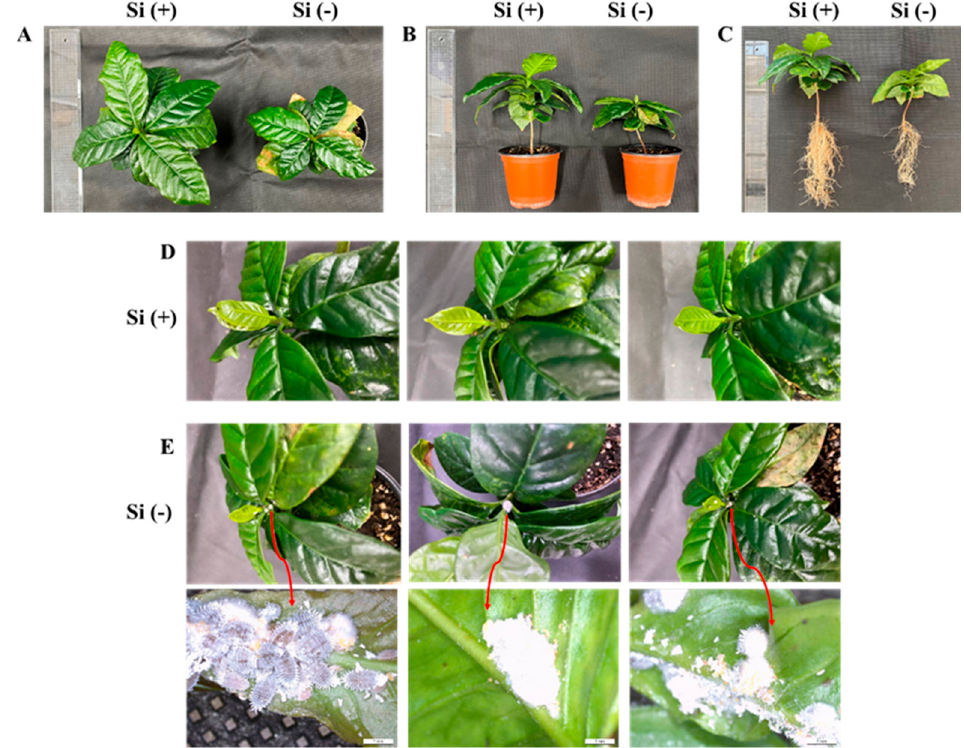
Figure 3. Effect of 30 days silicon application on morphology ( A – C ), disease, and insects ( D , E ) in the coffee plants grown in plant growth chambers. Si (+) and Si ( − ) refer to 75 and 0 mg·L − 1 , respectively. The red arrows indicate high magnification microscope photographs of plant disease or insects. Bars indicate 1 mm.